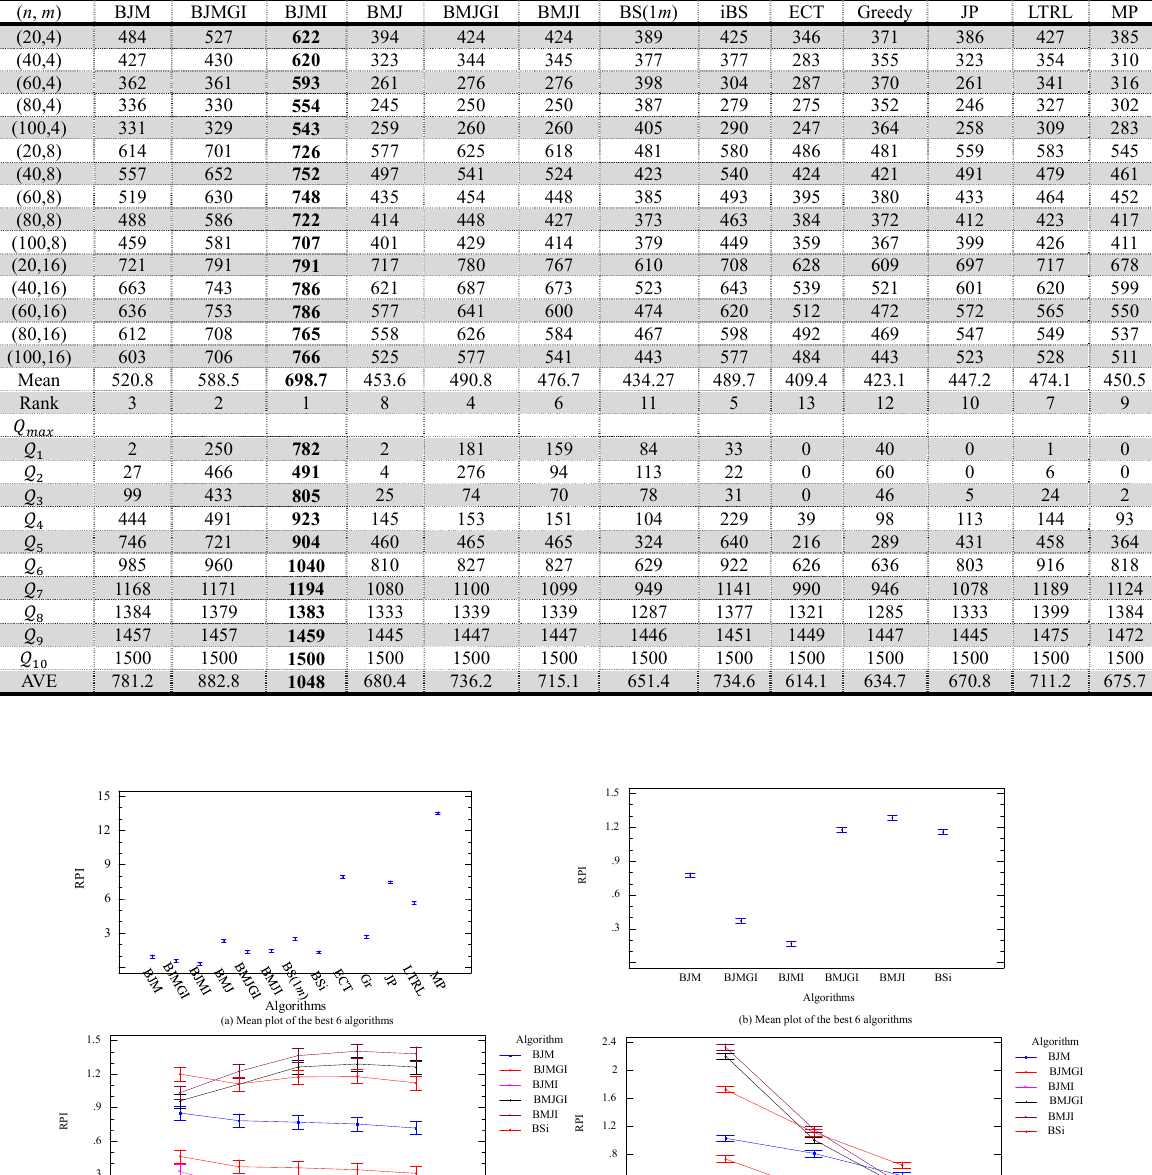
NSR for heuristics (large instances)